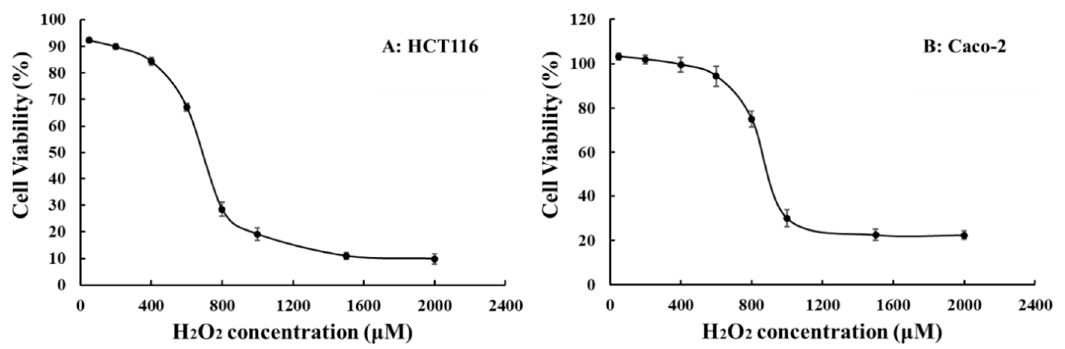
Figure 6. The cell viability of di ff erent cell lines against the H 2 O 2 concentration (( A ): human colorectal cells (HCT116); ( B ): heterogeneous human epithelial colorectal adenocarcinoma cells (Caco-2)).